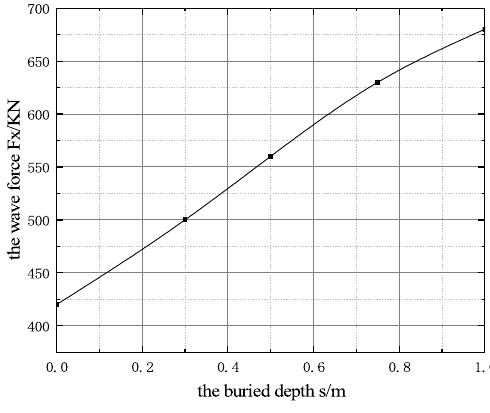
Fig. 9 F and F variation curves under different buried depth X Xmax